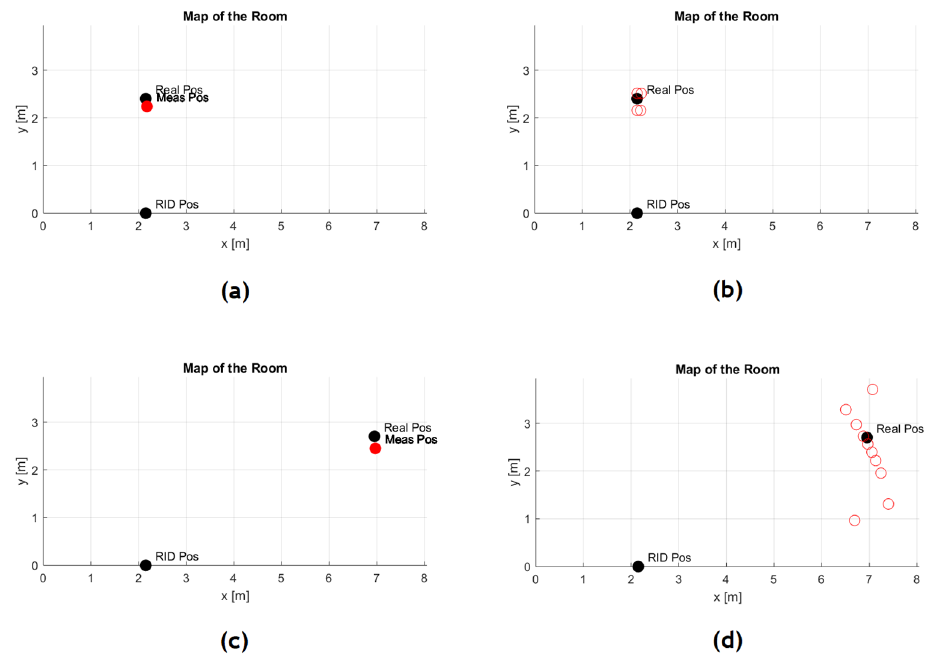
Figure 10. Example of a Drool rule present in the AI module.